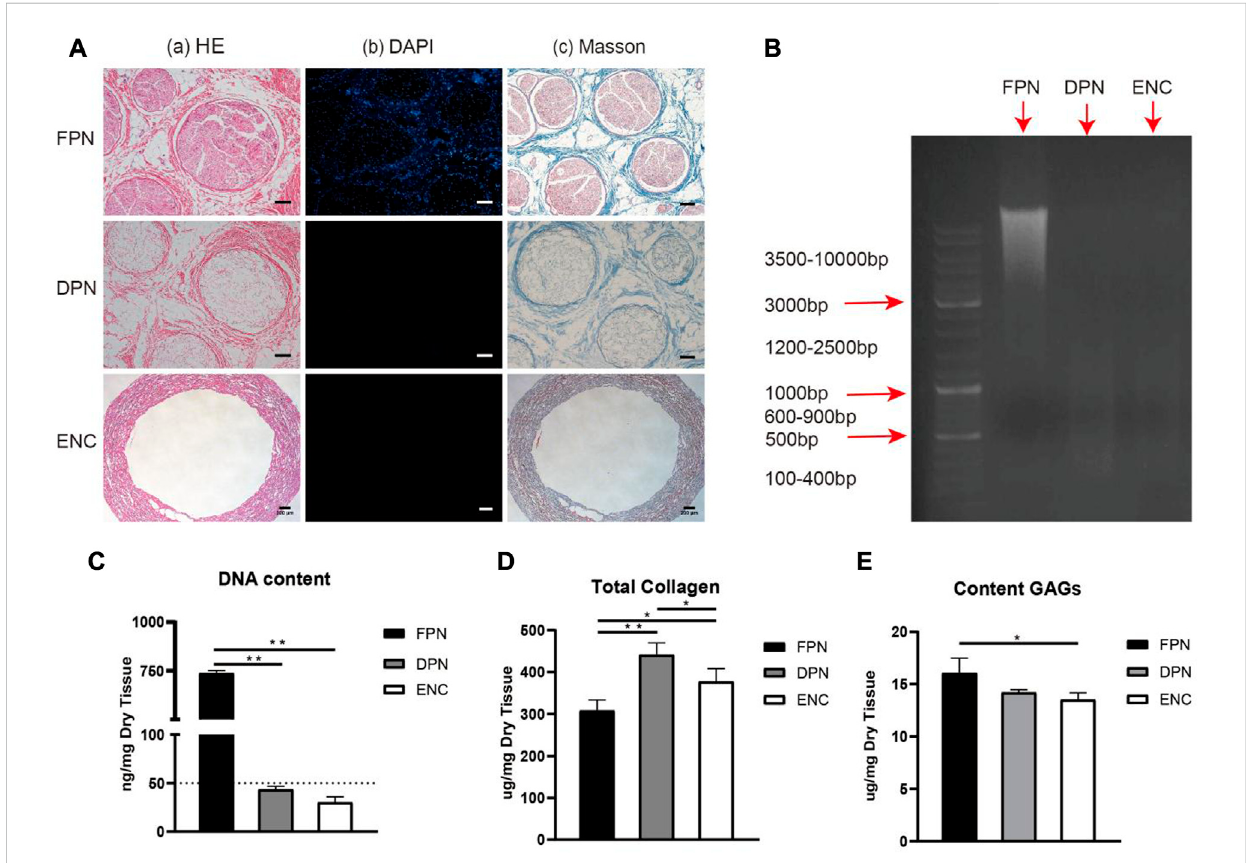
FIGURE 2 TheevaluationoftheextentofdecellularizationandthepreservationofECMcomponents.TheHE (A – A) andDAPI (A – B) stainingwereperformedto evaluate the removal of cells. The Masson trichrome staining (A – C) showed the integrity and distribution of collagen after decellularization and electrospun. (B) The DNA remnants were analyzed further by agarose gel electrophoresis. (C) The detection of DNA content. (D) The detection of total collagen. (E) ThedetectionofGAG.ForFPNandDPN,scalebar=100 μ m,forENC,scalebar=200 μ m.Dataareexpressedasthemean±SD( n =5) (* p < 0.05, ** p <